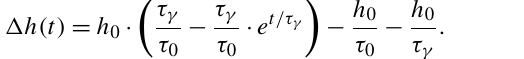
percentage ice volume change, a constant horizontal ice sur- face area was assumed which renders the analysis concep- tual in nature. Thus the quantitative interpretation of the melt times are subject to this additional